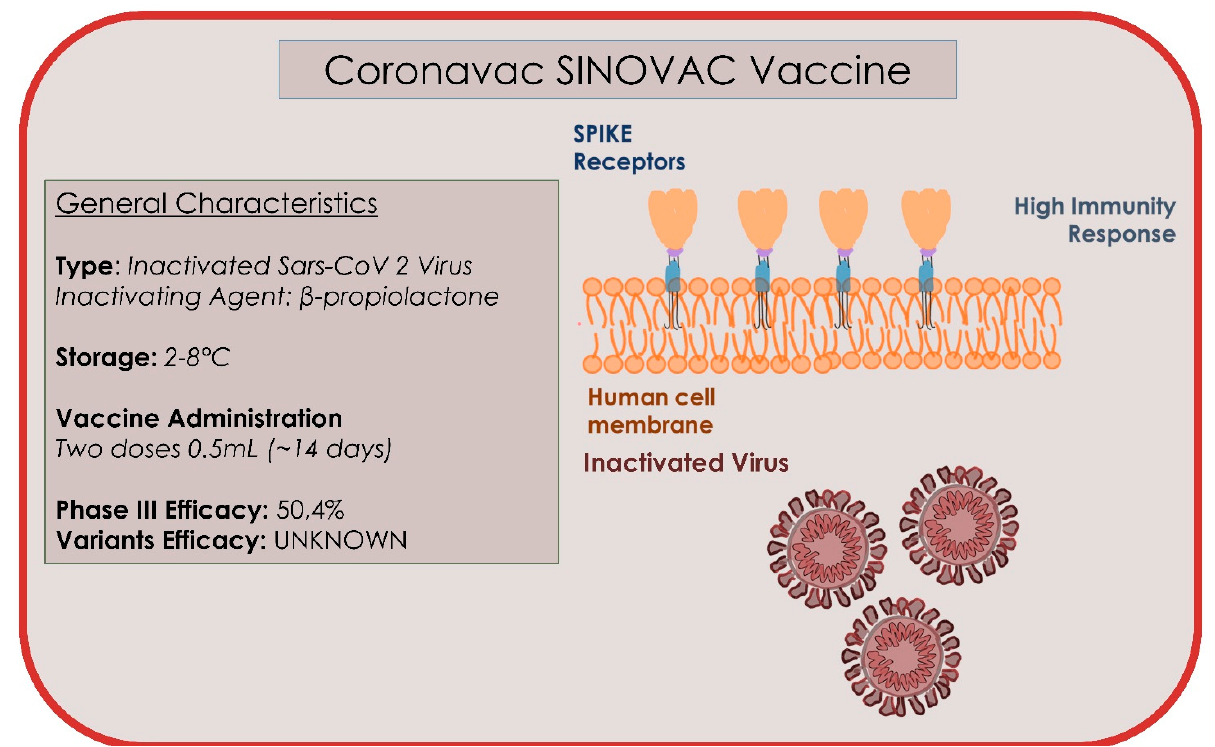
Figure 10. Summary of the type, storage administration, and efficacy characteristics of Coronavac vaccine.